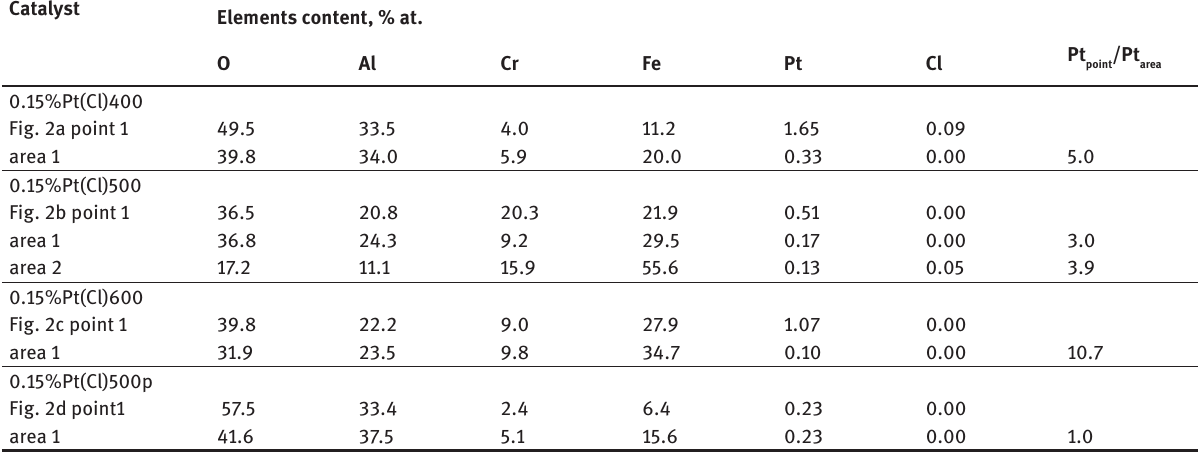
Table 3: Elemental composition (EDS) of selected areas and points on surface of 0.15%Pt(Cl) catalysts calcined in different conditions. Catalyst Elements content, %